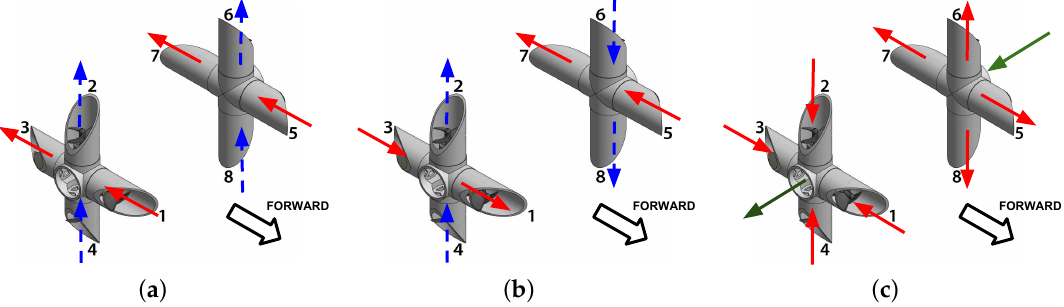
Figure 4. Thruster direction for UV movement. ( a ) Surge (red) and Heave (blue) motions; ( b ) Yaw (red) and Roll (blue) motions ( c ) Sway motion (red) and flow force direction (green).